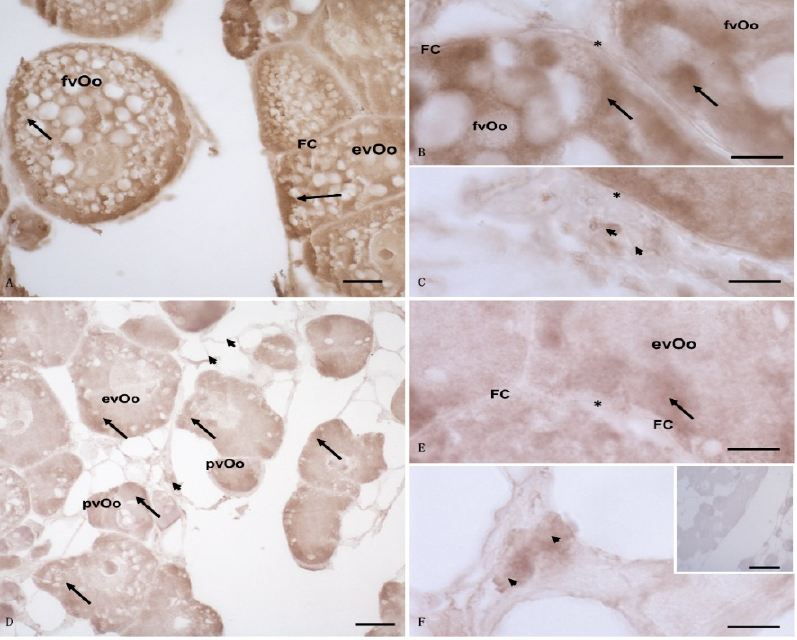
Figure 3. Light micrographs of Anguilla anguilla ovaries from control ( A – C ) and exposed ( D – F ) specimens. Immunolabeling with anti-3 β -HSD antibody. ( A – C ) a wide and strong positive reaction (arrow) was visible at the level of the fully vitellogenic oocytes (fvOos) and early vitellogenic oocytes (evOos); a weak signal was evident in the follicular (FCs) and theca cells (asterisk) as well as in the connective tissue (arrowheads). ( D – F ) Previtellogenic oocytes (pvOos) and early vitellogenic oocytes (evOos) were immunolabeled. In these cells, the immunohistochemical signal was in the cytoplasm as spots (arrow). A weak signal was evident in the connective cells (arrowheads). No positivity was found in the follicular (FCs) or theca (asterisk) cells. ( F insert ) Negative control: no labeling was evident in the ovary. Bars: ( A ) = 20 µm; ( B , C , E , F ) = 5 µm, ( D ) = 50 µm, ( F inset ) = 100 µm.